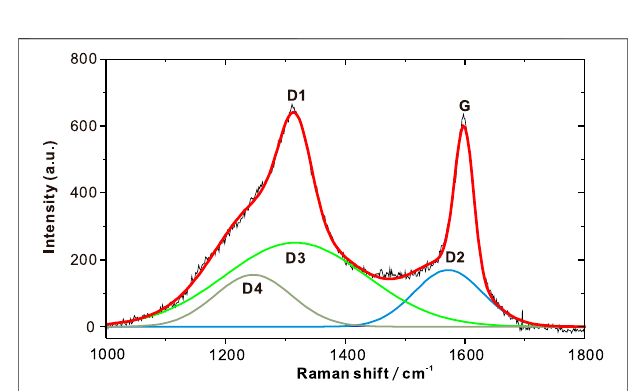
FIGURE 7 | Curve fi tting of Raman spectrum for a representative